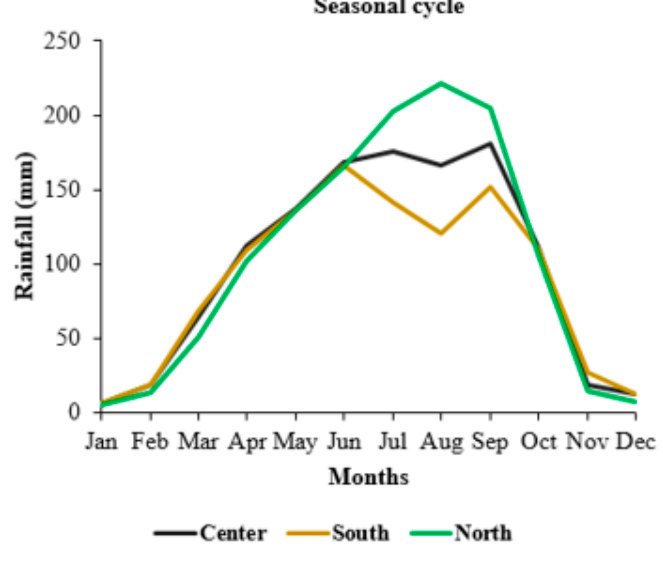
Figure 2. Rainfall seasonal cycles in Mono watershed.